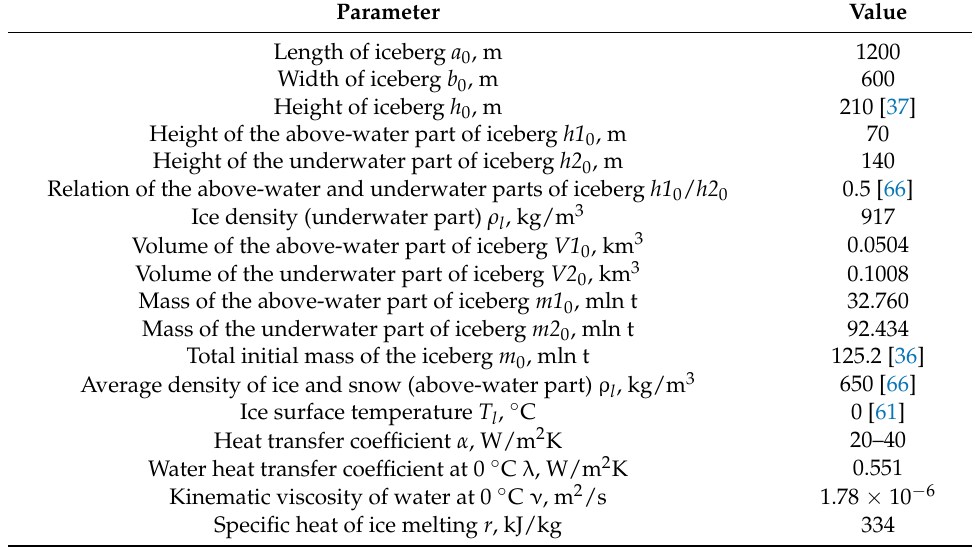
Table 4. Basic parameters used for calculation (own